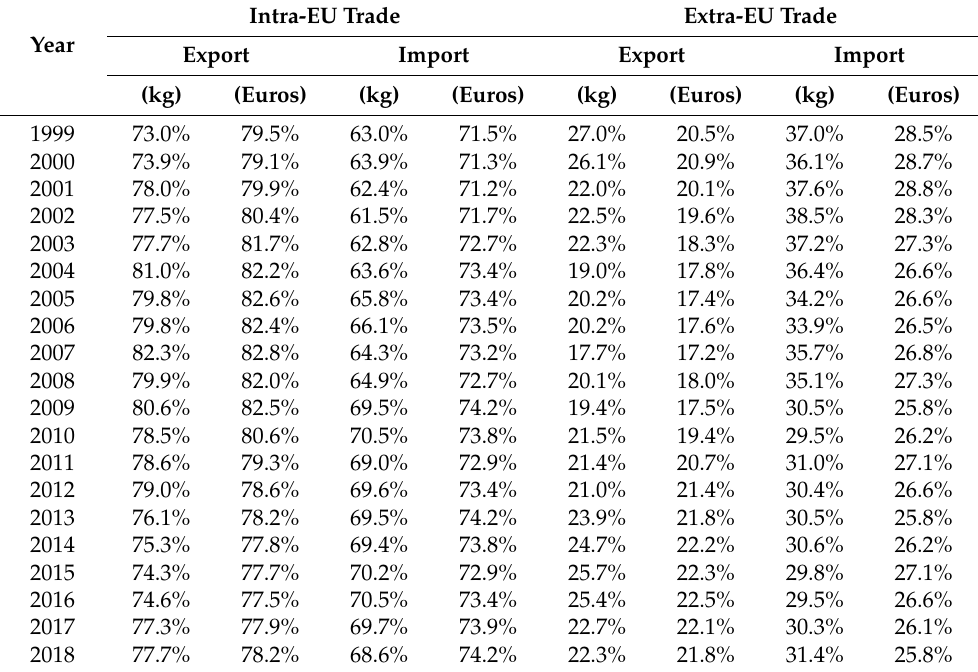
Table 1. Percentage of intra-EU and extra-EU food trade according to the Eurostat (the Standard International Trade Classification